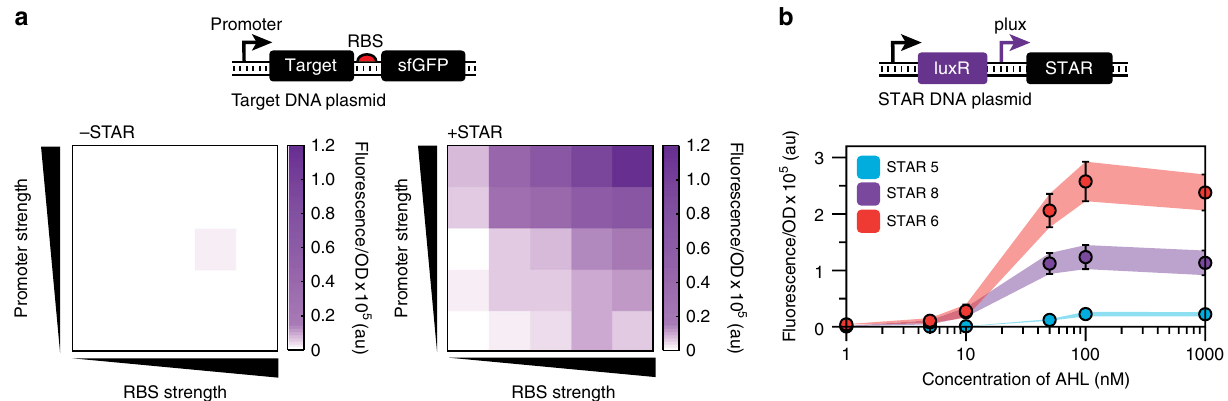
Fig. 2 STARs can interface with constitutive and inducible control elements to switch and tune regulatory properties. a STARs make constitutive gene expression elements switchable. Schematic DNA template of a library of target DNA plasmids containing variable strength promoters and ribosome binding sites (RBS). Fluorescence characterization of E. coli cells transformed with this library in the absence (left grid, -STAR) and presence (right grid, +STAR) of a plasmid encoding cognate STAR (raw data shown in Supplementary Fig. 13). b STARs tune inducible promoters. Schematic DNA template of a plasmid in which the plux promoter controls STAR production in response to acyl-homoserine lactone (AHL). Fluorescence characterization of E. coli cells transformed with this plasmid and a plasmid encoding a target RNA construct controlling sfGFP expression and exposed to a range of AHL concentrations. Changing the STAR:target pair in this con fi guration results in unique induction curves. Fluorescence characterization was performed by bulk fl uorescence measurements (measured in units of fl uorescence [FL]/optical density [OD] at 600nm). Data represent mean values and error bars represent s.d. of n =